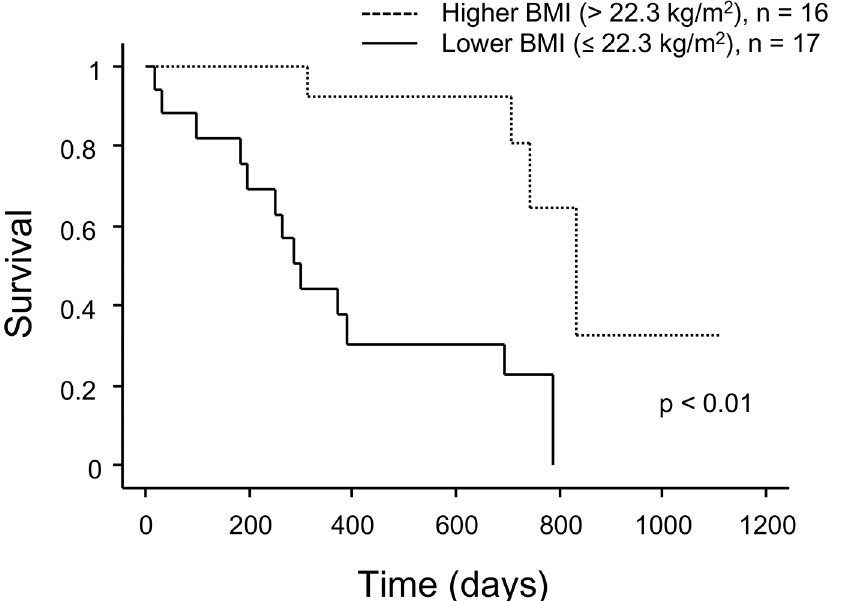
Fig 4. Kaplan − Meier survival curves for candidates with idiopathic pulmonary fibrosis grouped based on BMI. p < 0.01 by log-ranktest. BMI, body mass index.